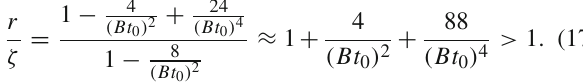
provides explicit analytical expressions for the